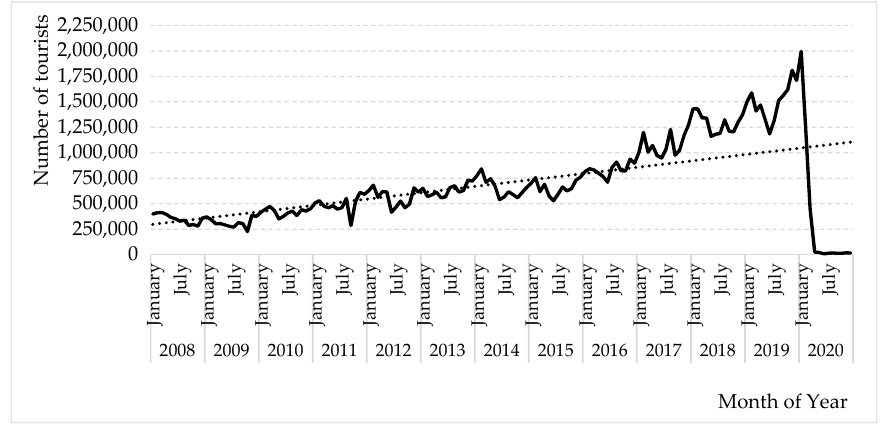
Figure 2 . Monthly numbers of international tourists arrivals in Vietnam and its trend (2008:01– 2020:12). Source: VNAT (2020).